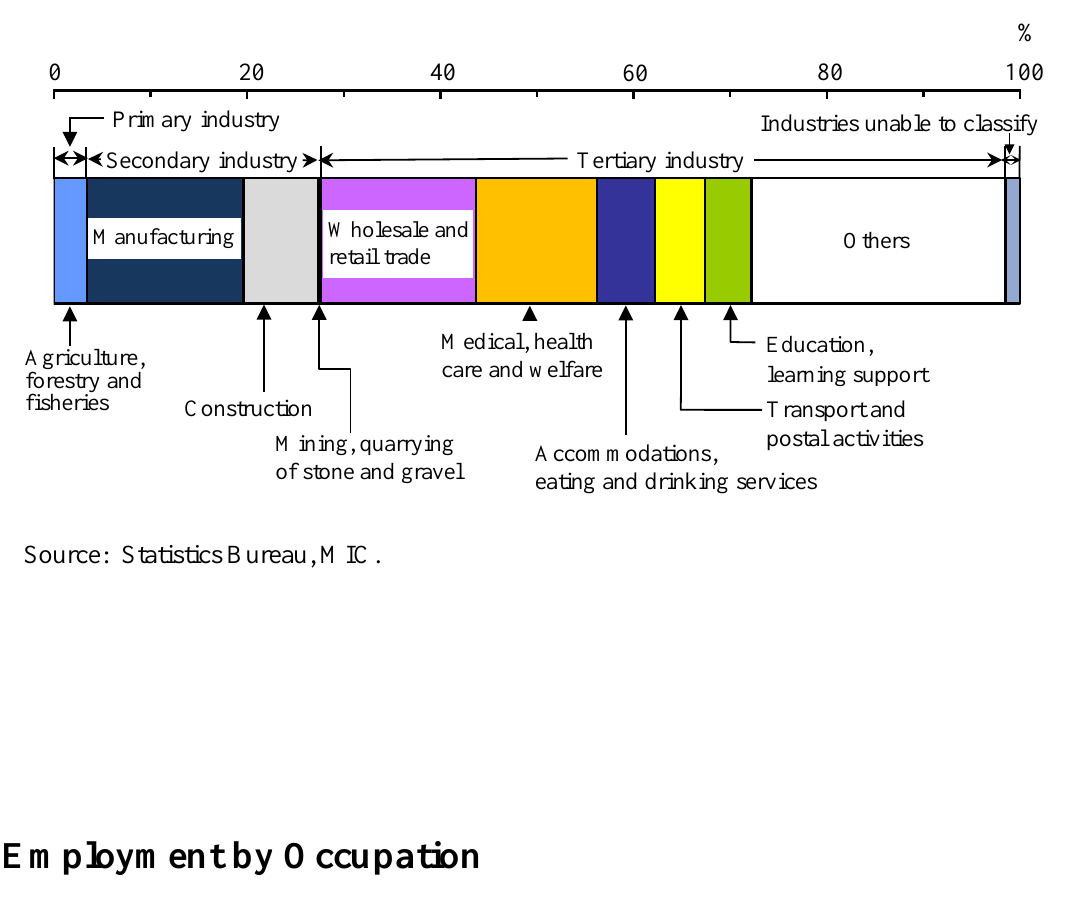
Distribution of Employment by Industry